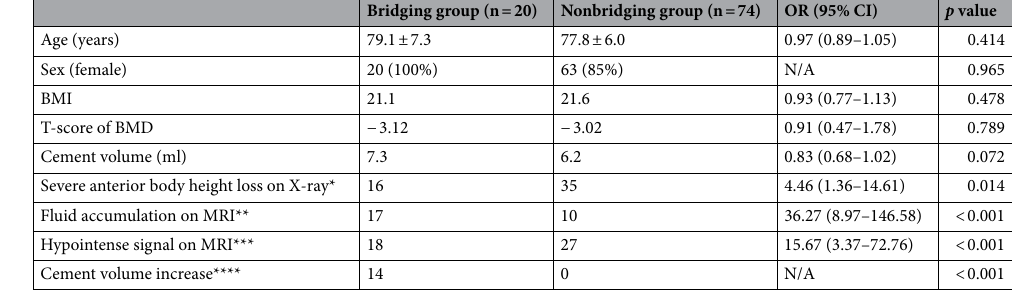
Table 1. Patient characteristics and imaging features of the bridging and nonbridging groups. *Severe loss (more than 50%) of anterior vertebral body height at the new-onset adjacent vertebra on X-ray. **Fluid accumulations around the space anterior to the abutting vertebral bodies and the corresponding intervertebral disc on MRI. ***Hypointense signal around the space anterior to the abutting vertebral bodies and the corresponding intervertebral disc on MRI. ****Cement volume increase in the previously augmented vertebra. BMI body mass index, BMD bone mineral density, OR odds ratio, CI confidence interval, N/A not applicable.